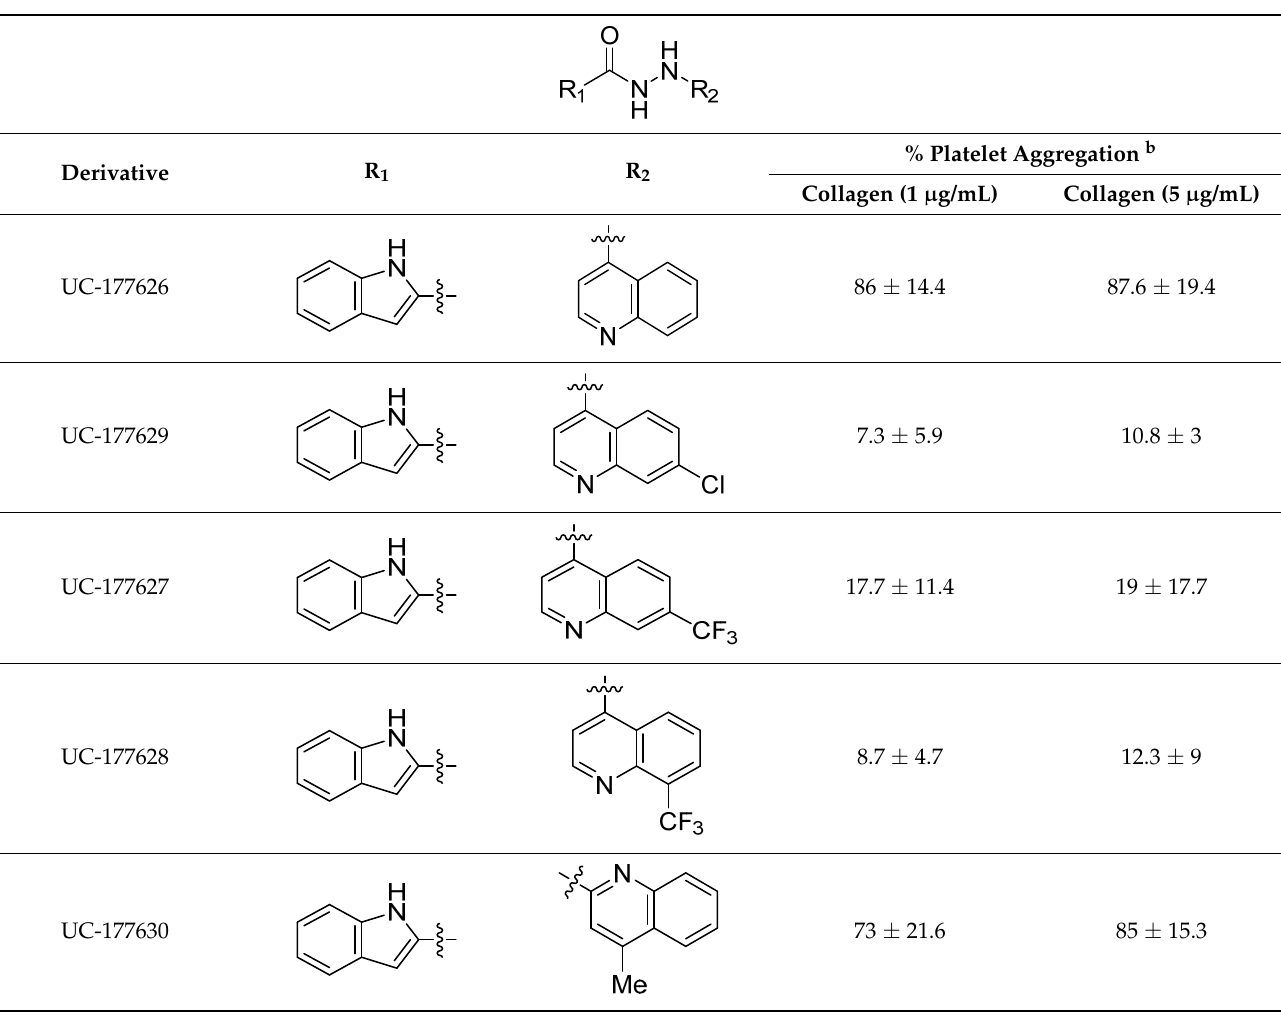
Table 2. Structures of compound UC-177629 analogs and their effects at 20 µM on in vitro collagen- induced platelet aggregation.